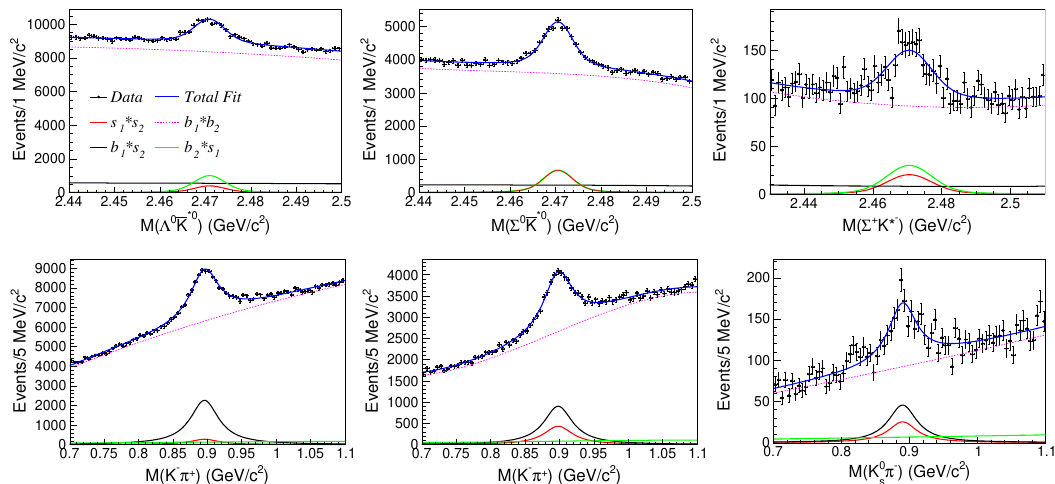
Figure 3 . 2D binned maximum-likelihood fits to M ( K − π + ) and M (Λ ¯ K ∗ 0 ) (left), M ( K − π + ) and M (Σ 0 ¯ K ∗ 0 ) (middle), and M ( K 0 π − ) and M (Σ + K ∗− ) (right) distributions from data samples. All S components are indicated in the labels and described in the